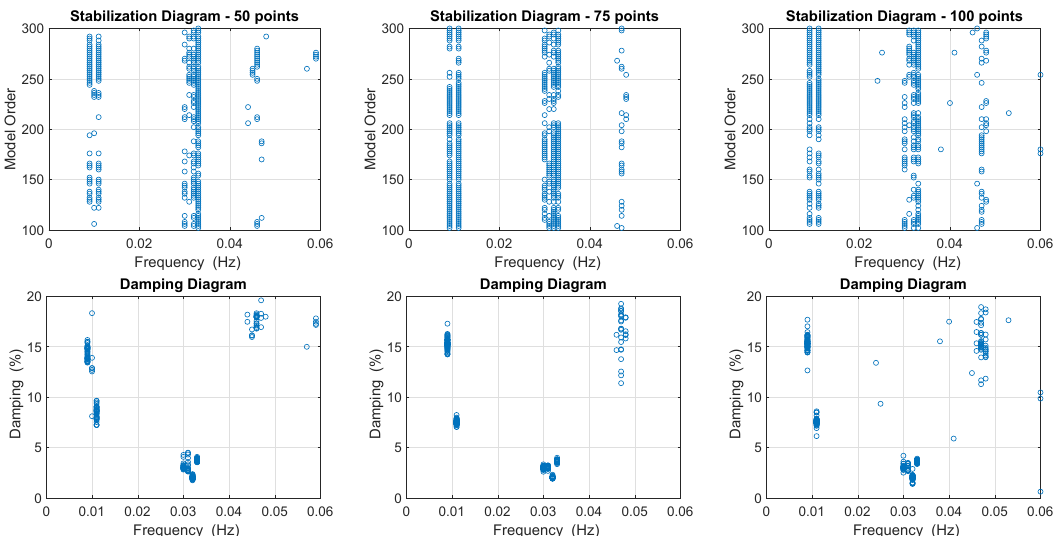
Figure 8. Stabilization and damping diagrams obtained considering 50 points (on the left), 75 points (in the middle), or 100 points (on the right) for the autocorrelation function length.